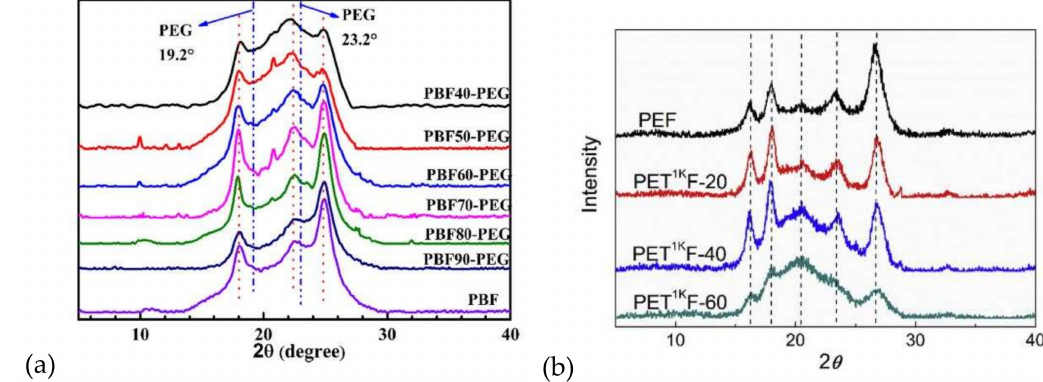
Figure 5. ( a ) XRD di ff ractograms of PBF- co -PEG block copolymers [89] and ( b ) PEF- co -PTMG block copolymers